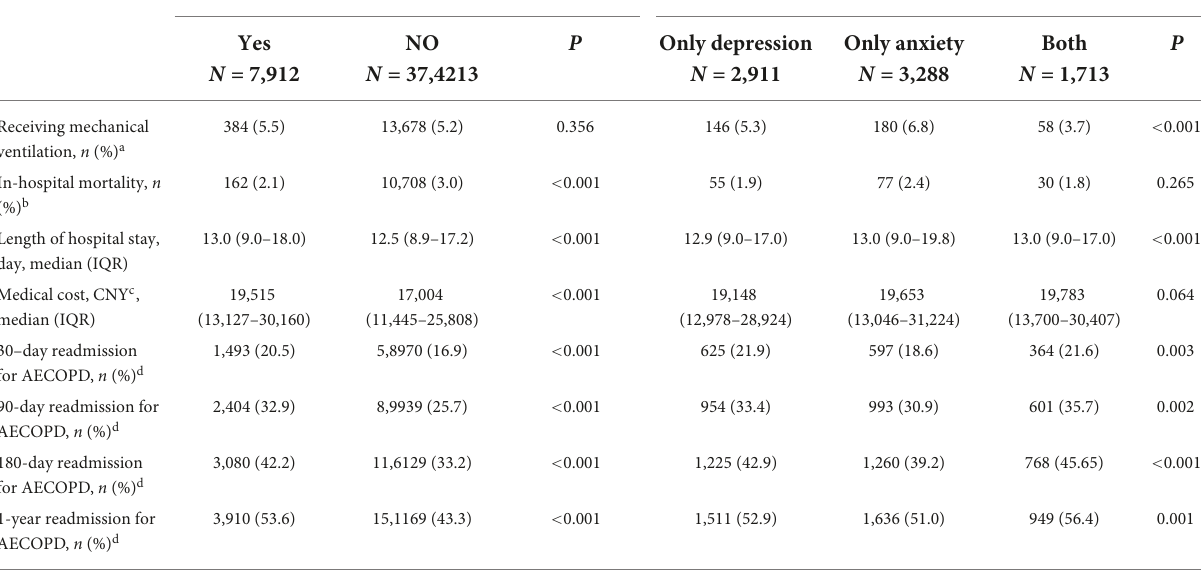
TABLE 3 The differences in in-hospital outcomes and the risks of readmission for AECOPD after discharge between those with anxiety and/or depression and those without. With anxiety and/or depression Subtypes Yes NO P Only depression Only anxiety Both P N = 37,4213